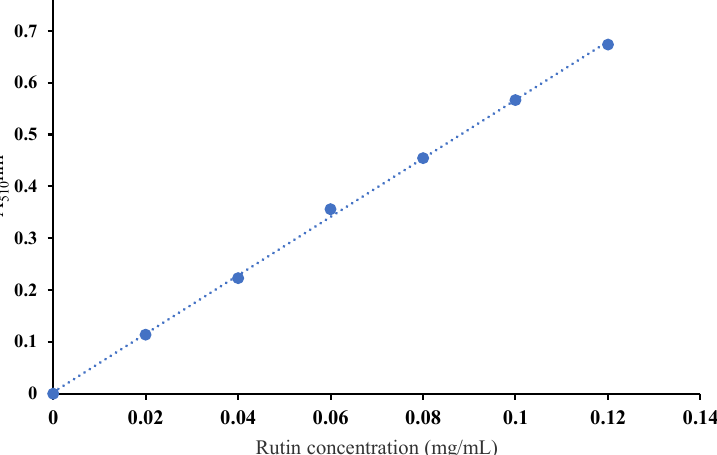
Figure 1. Rutin standard curve. The regression equation of the standard curve of the rutin standard is y = 5.6429x + 0.0027, R 2 = 0.9992.